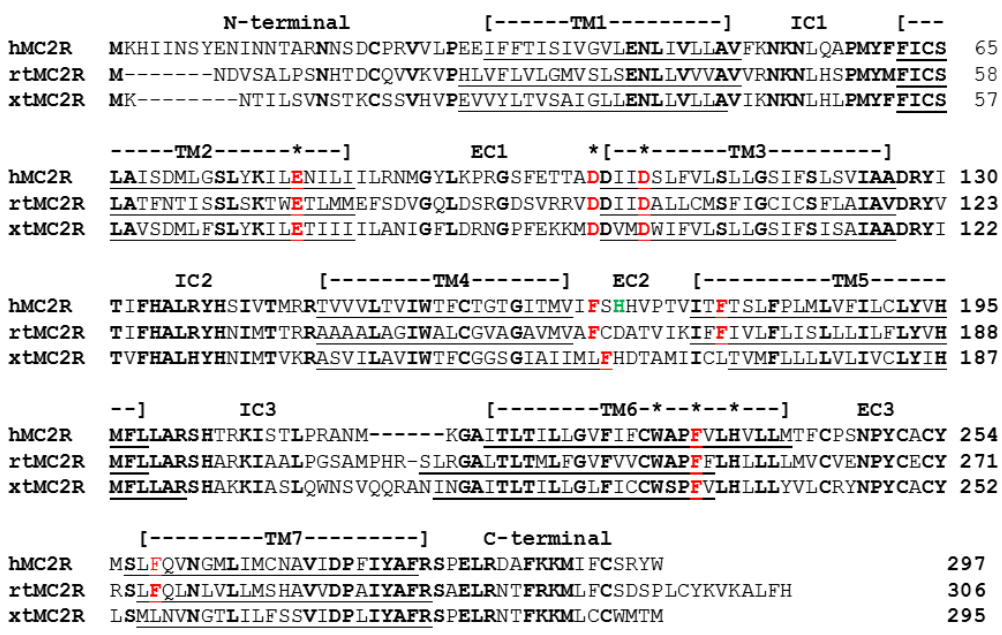
Figure 1. Alignment of Human, Rainbow Trout, and Xenopus tropicalis MC2R Orthologs. The amino acid sequences of human hMC2R (accession number: AA067714.1), rainbow trout (rtMC2R; Onchorhynchus mykiss ; accession number: EU119870) and Xenopus tropicalis (xtMC2R; accession number: XP002936118.1) were aligned based on primary sequence identity. The TMHMMServer, v. 2.0-DTU (http://www.cbs.dtu.dk/services/TMHMM-2.0//) was used to identify transmembrane domains (TM; underlined). The locations of the transmembrane domains (TM), intracellular loops (IC), and extracellular loops (EC) of hMC2R are labeled. Amino acid positions in human MC2R that are proposed to be in the HFRW binding site [10] are marked with a (*). The amino acid positions in hMC2R that Chen et al. [11] identified as essential for activation are highlighted in red. H170 in EC2 that Chung et al. [12] identified as essential for activation is highlighted in green. The number of positions that are identical in all three sequences is 38%.